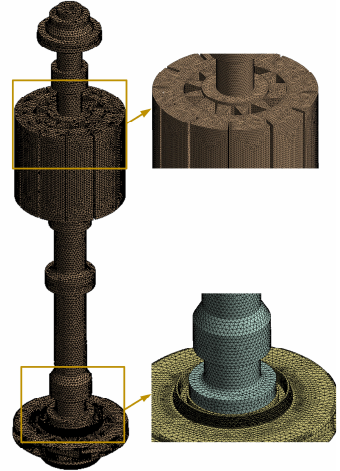
Figure 3. Three ‐ dimensional structural mesh model of the rotor system. Figure 3. Three-dimensional structural mesh model of the rotor system.